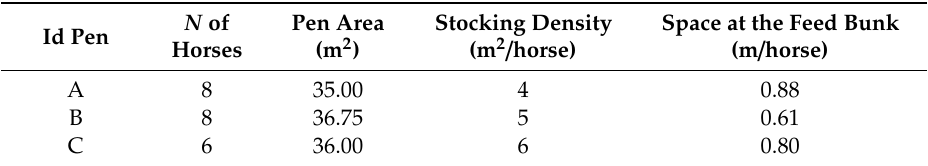
Table 1. The number ( N ) of horses, pen area (m 2 ), stocking density (m 2 / horse), and space at the feed bunk (m / horse) within each pen are